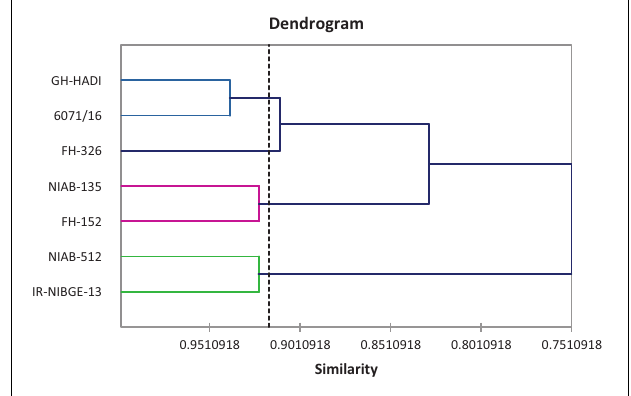
FIGURE 14 | Tree diagram based on biochemical traits for different cotton genotypes under control and salt stress conditions.